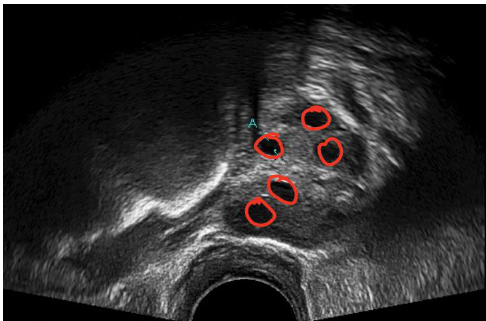
Figure 8. Image of identified follicles marked by medical expert.